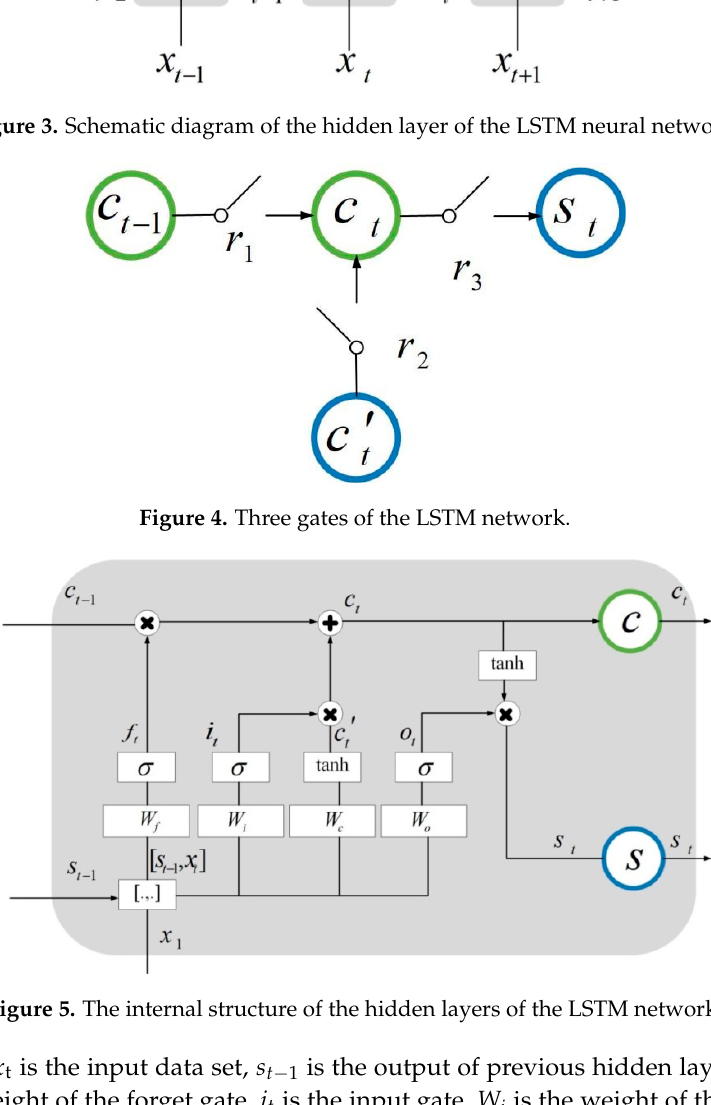
Figure 5. The internal structure of the hidden layers of the LSTM network.